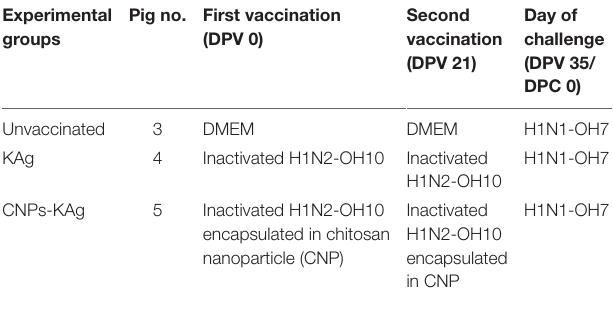
TaBle 1 | Experimental design showing different vaccine groups. experimental